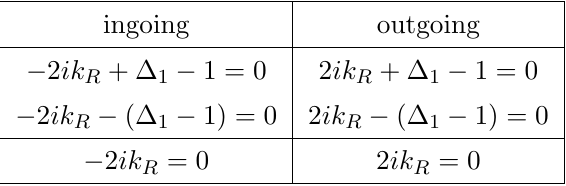
Table 6 . Additional spin-1 ghost states that are consistent with the Neumann conditions on g ++ , but are not contained in the Brown-Henneaux states. The (cid:12)rst two lines correspond to new m 1 > 0 states, whereas the k R = 0 states arise both in the m 1 > 0 and m 1 < 0 sectors. taking (cid:1) ! 1 is straightforward. However, in the (cid:12)rst (Neumann) factor it appears 2